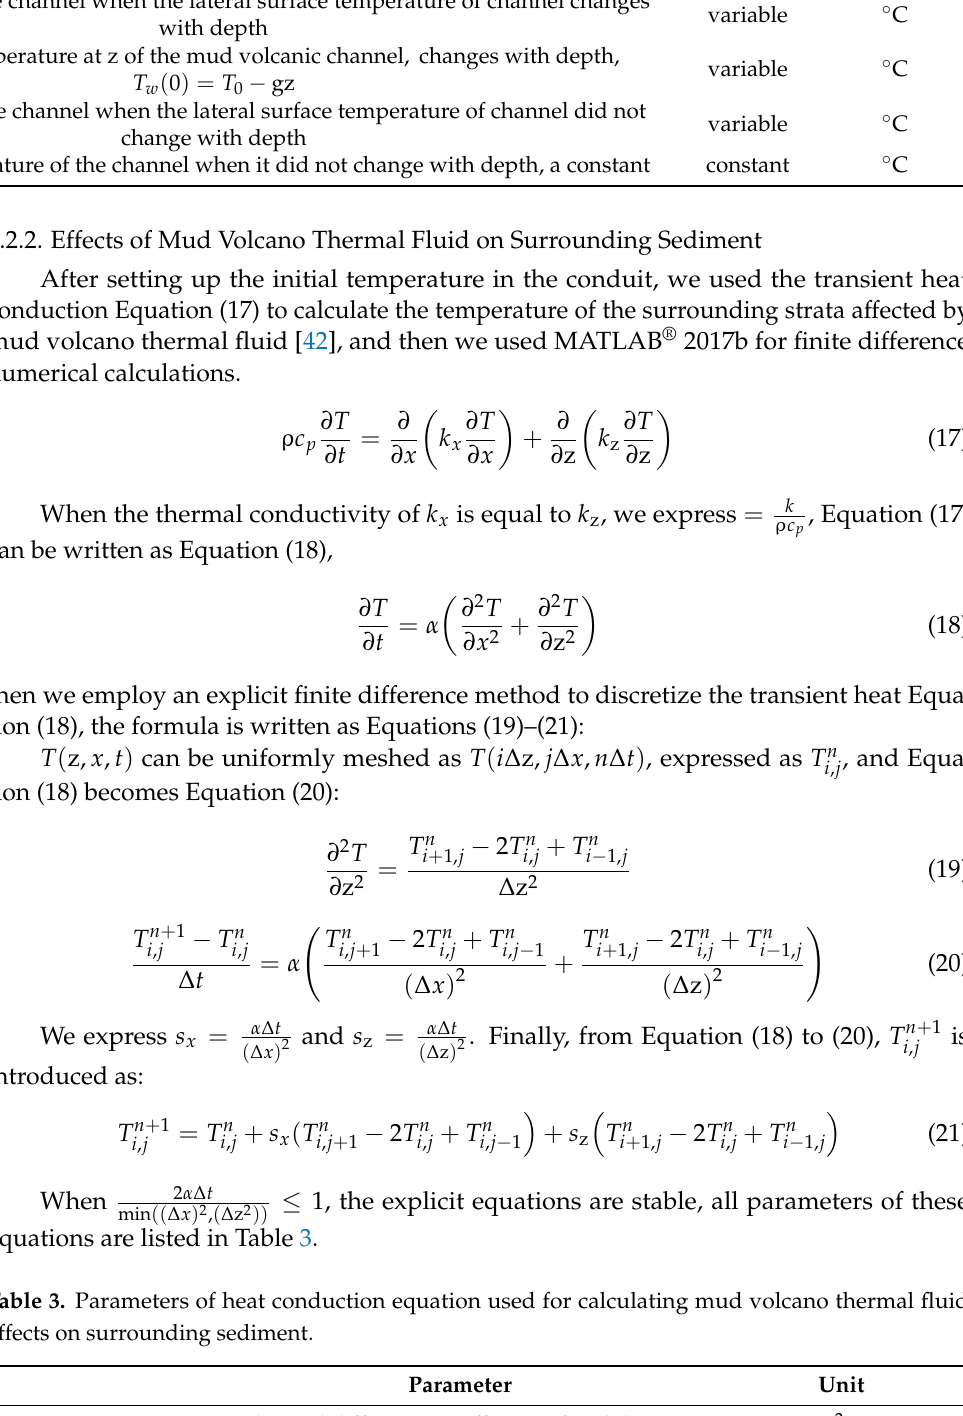
Table 2. Cont. Parameter Value Unit mean inlet temperature of the mud volcano 185 perpendicular distance from mud volcano original layer variable